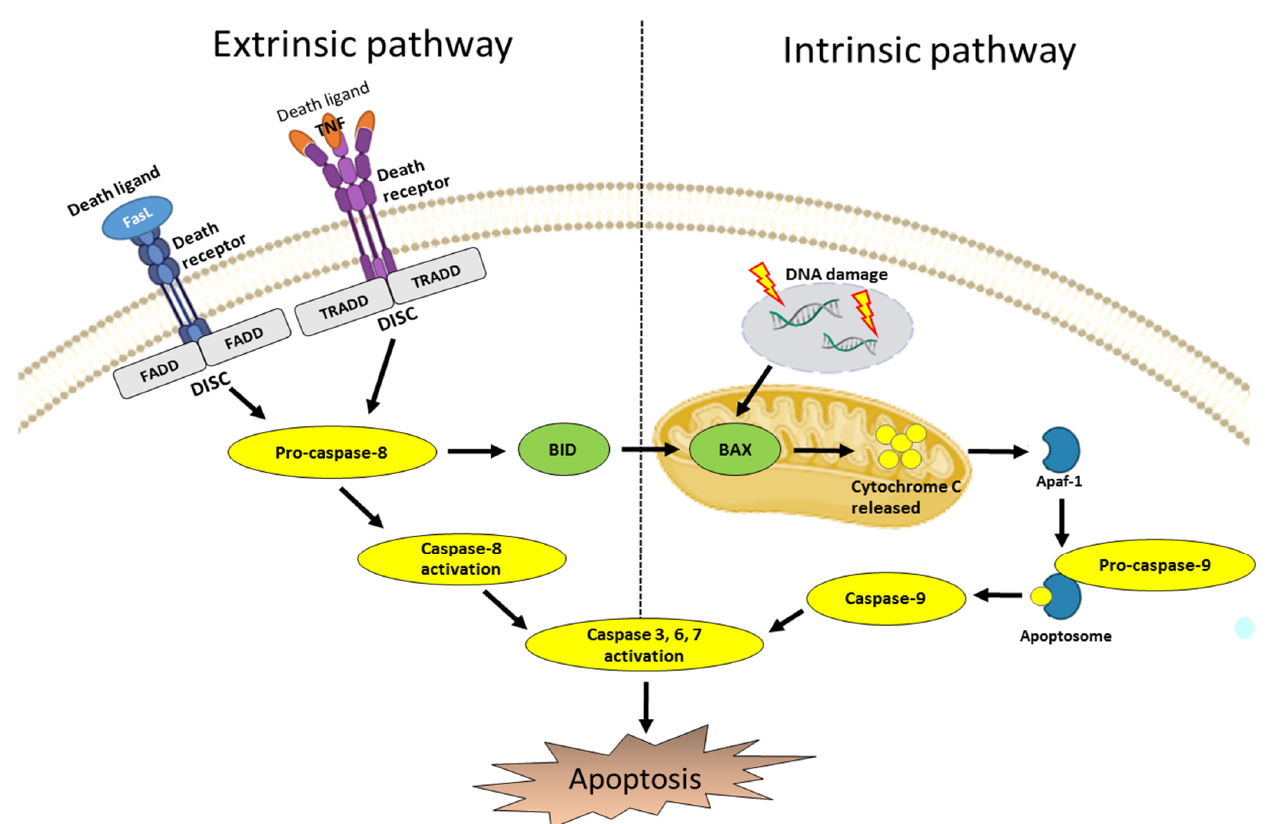
Figure 3. The extrinsic and intrinsic pathways of apoptosis.